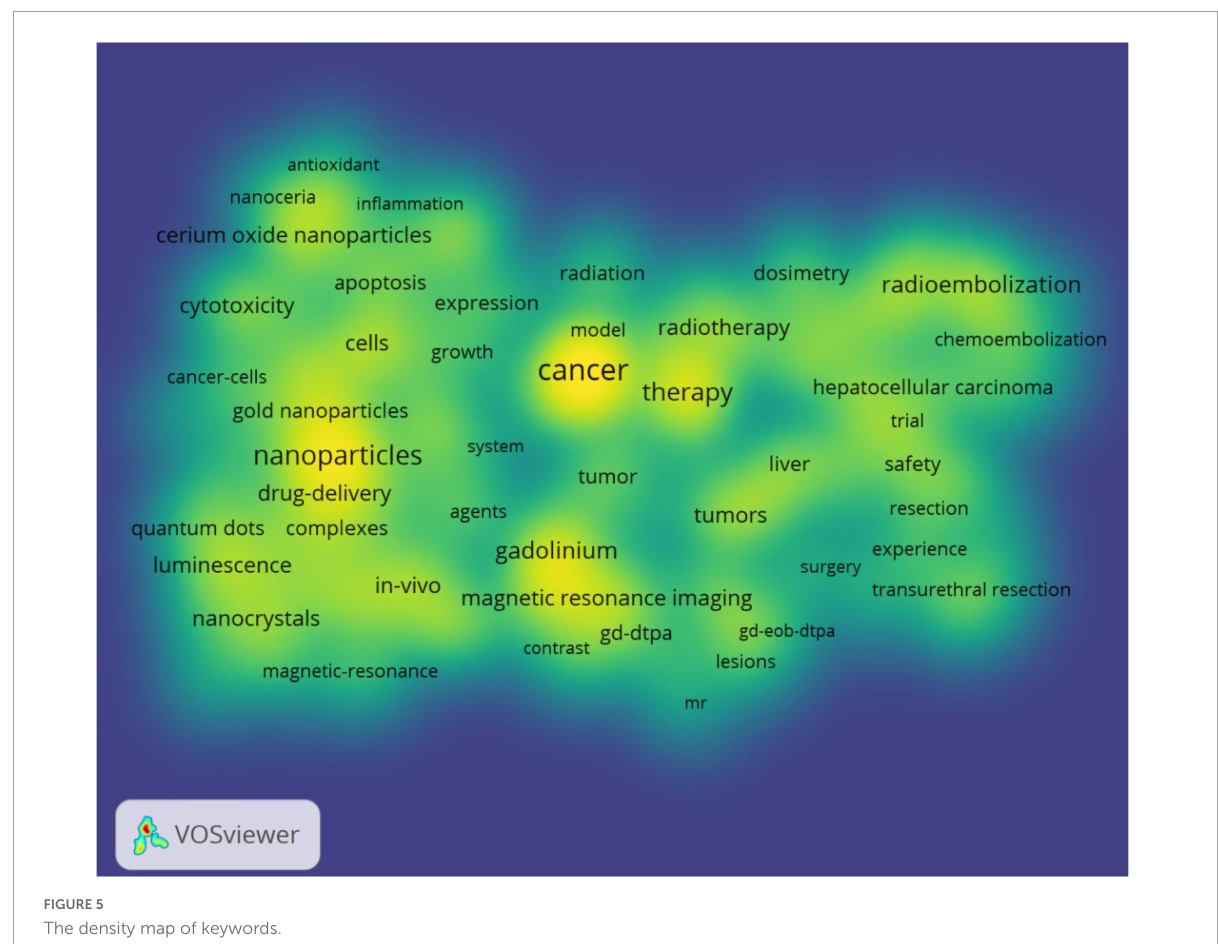
FIGURE5 The density map of